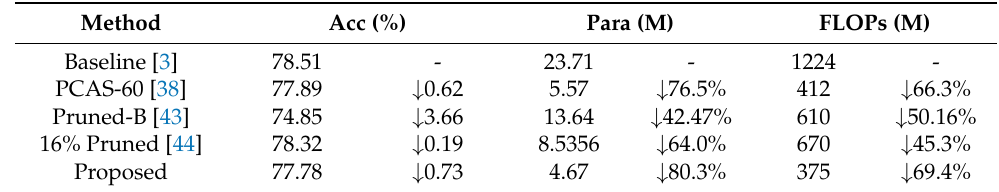
Table 1. Comparison of different pruning algorithms for ResNet50 on CIFAR-100.